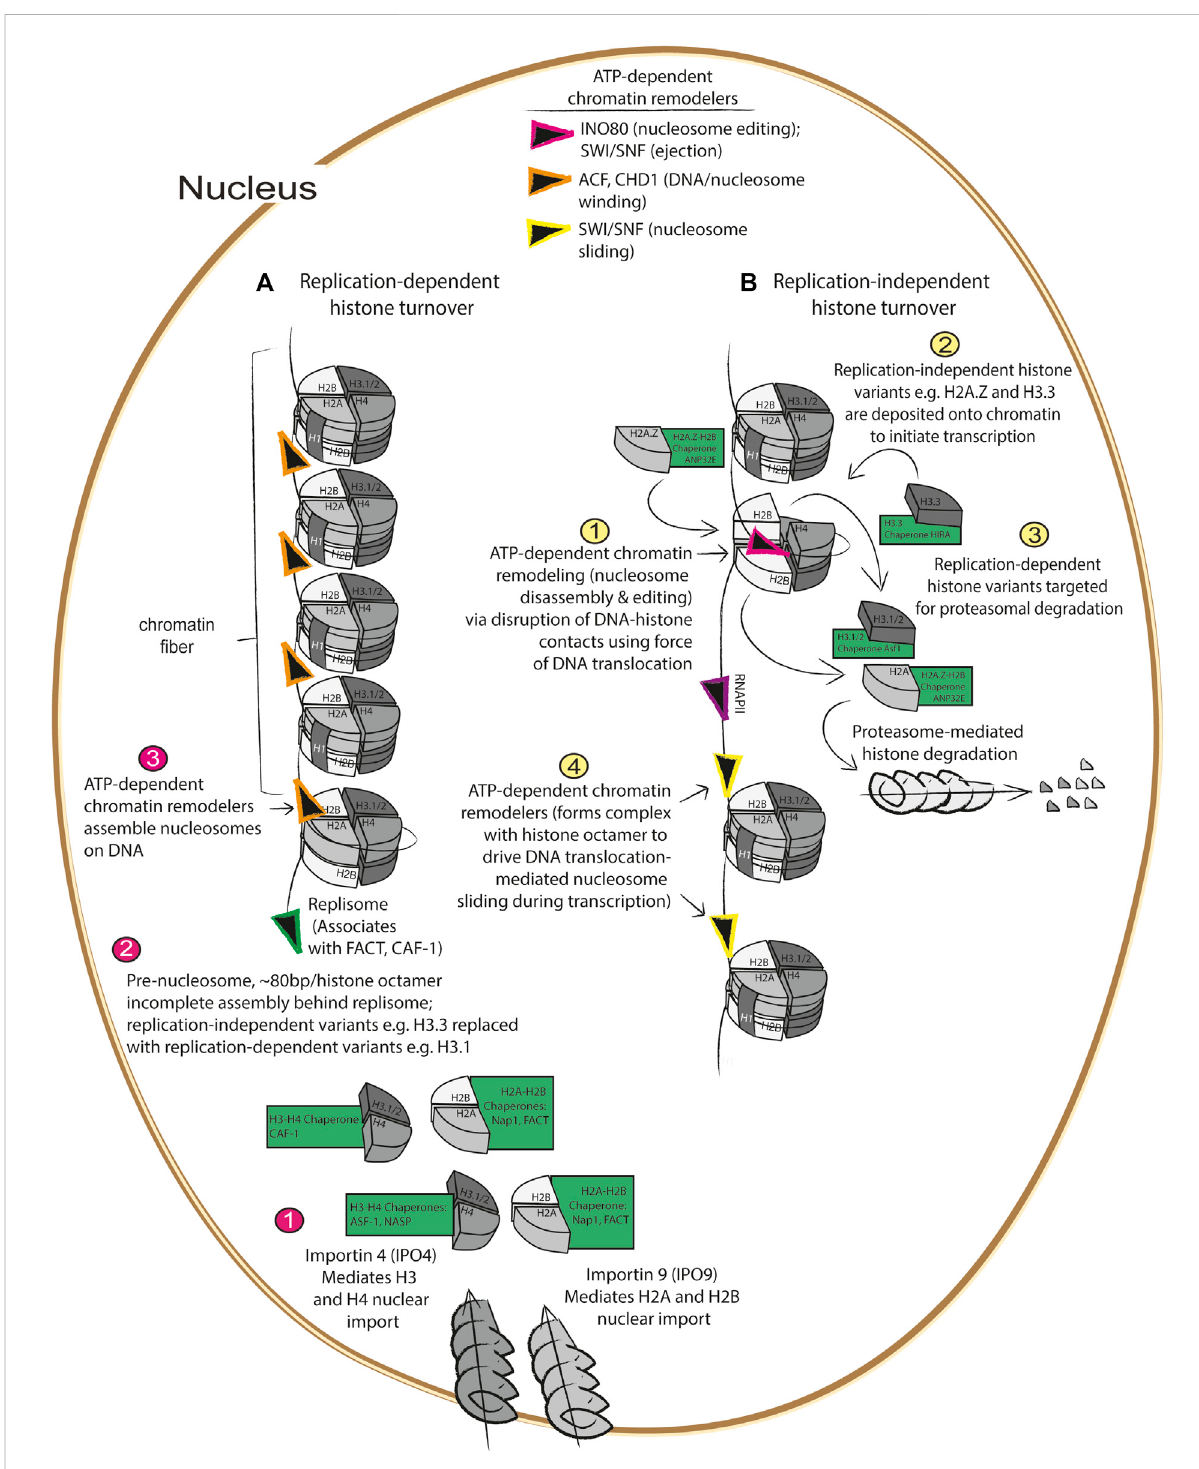
FIGURE 1 Replication dependent and independent histone turnover mediated by histone chaperones ATP-dependent chromatin remodelers (A) 1) Import of newly synthesized histones are imported by importins (Jakel et al., 2002; Soniat et al., 2016) at the nuclear membrane which are then recognized by their cognate histone chaperones where 2) they are assembled with newly synthesized DNA into pre-nucleosomes behind the DNA replisome (Fei et al., 2015), followedby3)maturationintoassembled,higherordernucleosomesviaATP-dependentchromatinremodelers(Lusseretal.,2005;Clapieretal.,2017). (B) Duringgenetranscription,1)nucleosomesaredisassembledbyhistonechaperonesandATP-dependentchromatinremodelers(Konevetal.,2007;Adam et al., 2013; Pchelintsev et al., 2013), 2) replication dependent histones are replaced with replication independent histone variants such as H3.3 and H2A.Z (Alvarez-Ponce et al., 2019), 3) replication-dependent variants are degraded via the proteasome (Oh et al., 2020), and 4) ATP-dependent chromatin remodelers mediate nucleosome sliding during transcription (Whitehouse et al.,